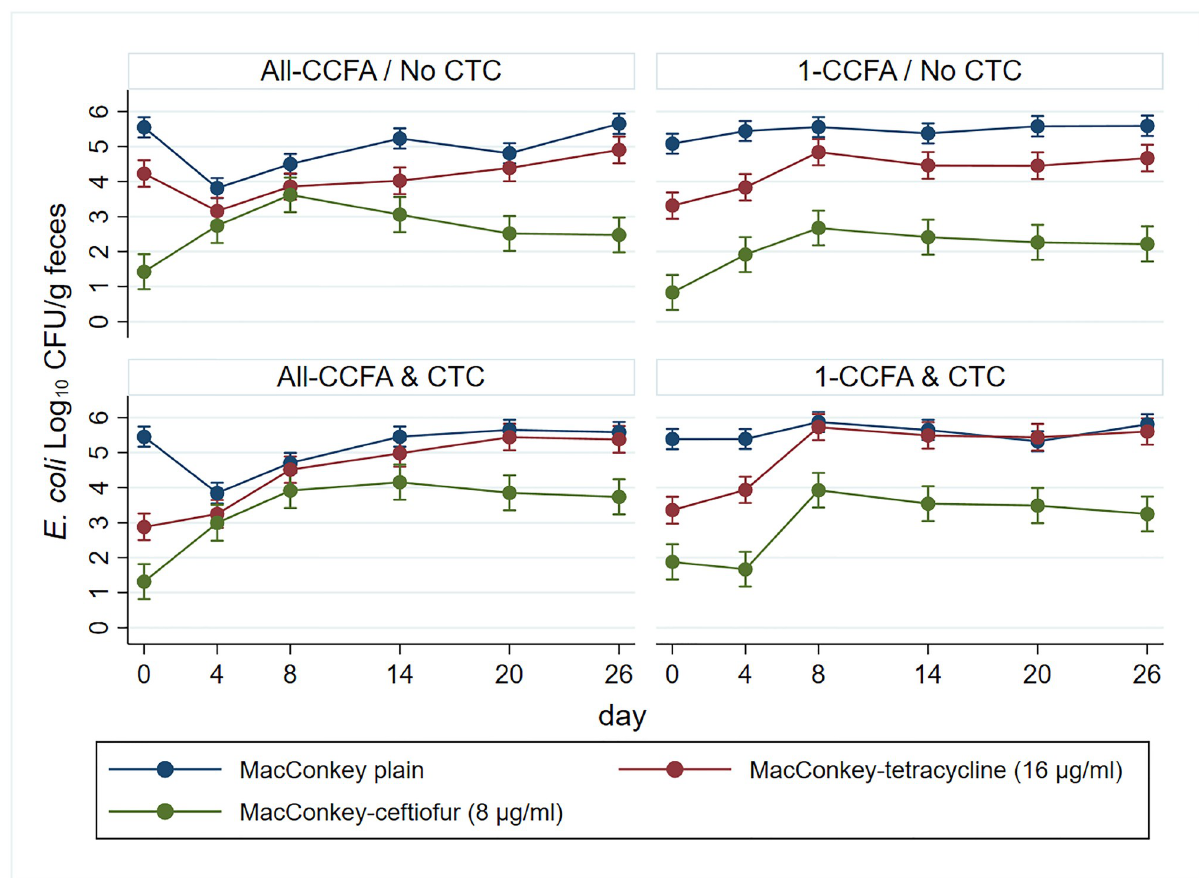
Fig 3. Quantity of E . coli was modeled by multilevel mixed linear regression. Blue: colony growth on plain MacConkey, red: colony growth on MacConkey-tetracycline, green: colony growth on MacConkey-ceftiofur.